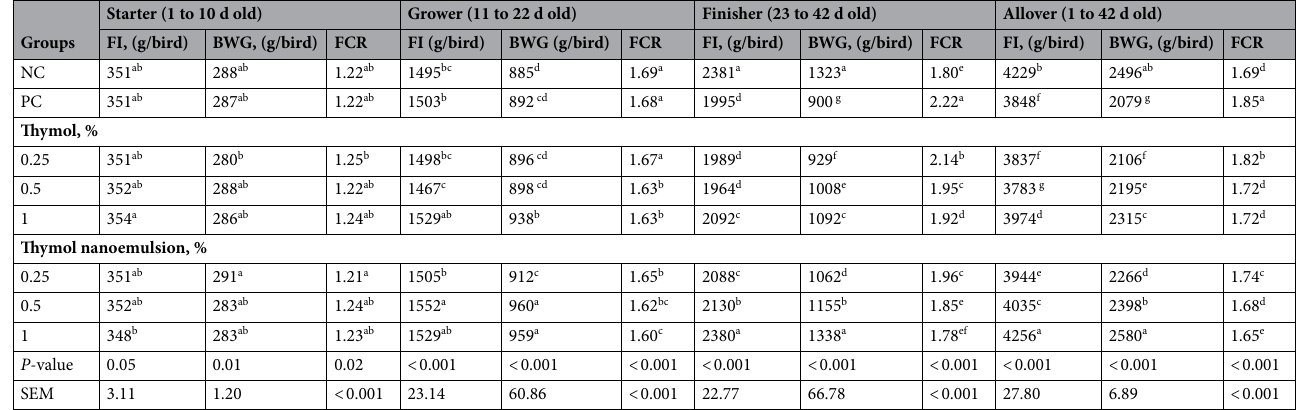
Table 1. Effects of thymol and thymol nanoemulsion on growth performance of Ross broilers (d 1 to 42) and challenged with Salmonella Typhimurium at d 23 of age. NC (negative control): birds fed basal diet; PC (positive control): birds fed basal diet and challenged with S . Typhimurium at d 23 of age; thymol 0.25, 0.5 and 1%: birds fed basal diet supplemented with 0.25, 0.5 and 1% thymol; thymol nanoemulsion 0.25, 0.5 and 1%: birds fed basal diet supplemented with 0.25, 0.5 and 1% thymol nanoemulsion. All groups except NC group were challenged with S. Typhimurium at d 23 of age. FI: feed intake; BWG: body weight gain; FCR: